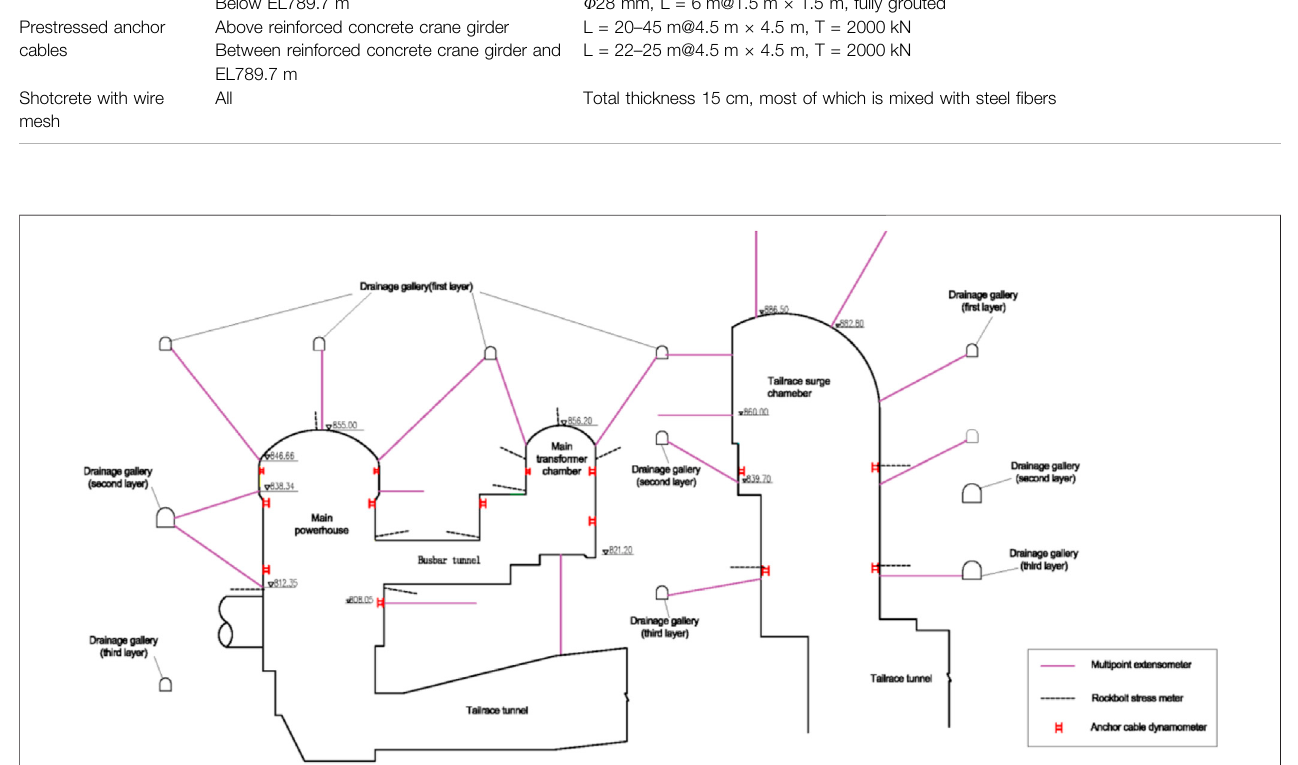
FIGURE 5 | Layout of the monitoring devices instrumented for one of the cross-sections of the underground powerhouse.